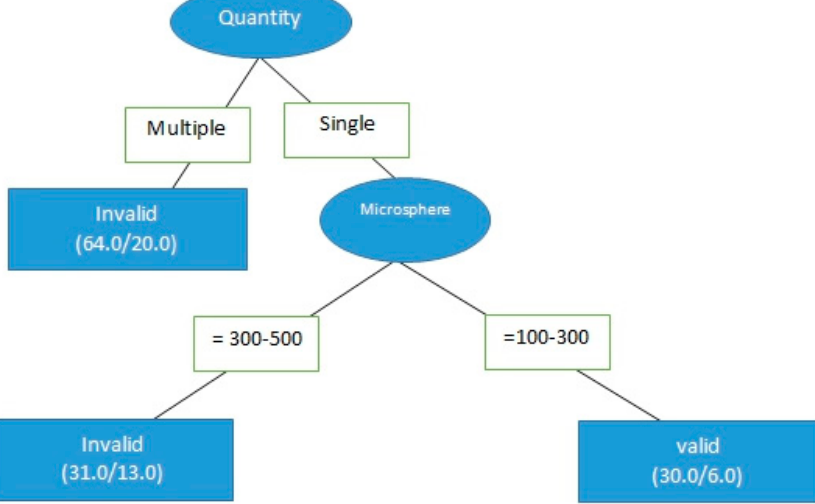
Figure 5. Decision tree classification, the same as the previous iteration but with 500–700 µ m-sized microspheres also excluded.